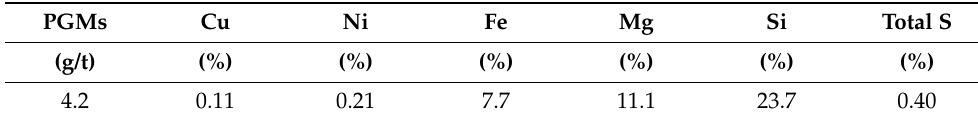
Table 4. Head grades of the Merensky ore.